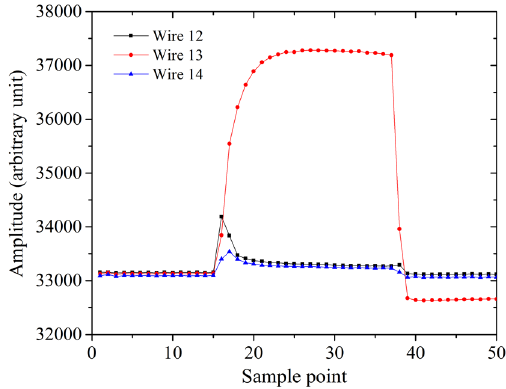
FIG. 8. Acquired signals from Wire 12, 13, and 14, at a sampling rate of 400 ksps. A bias voltage of − 30 V is applied to the wires.